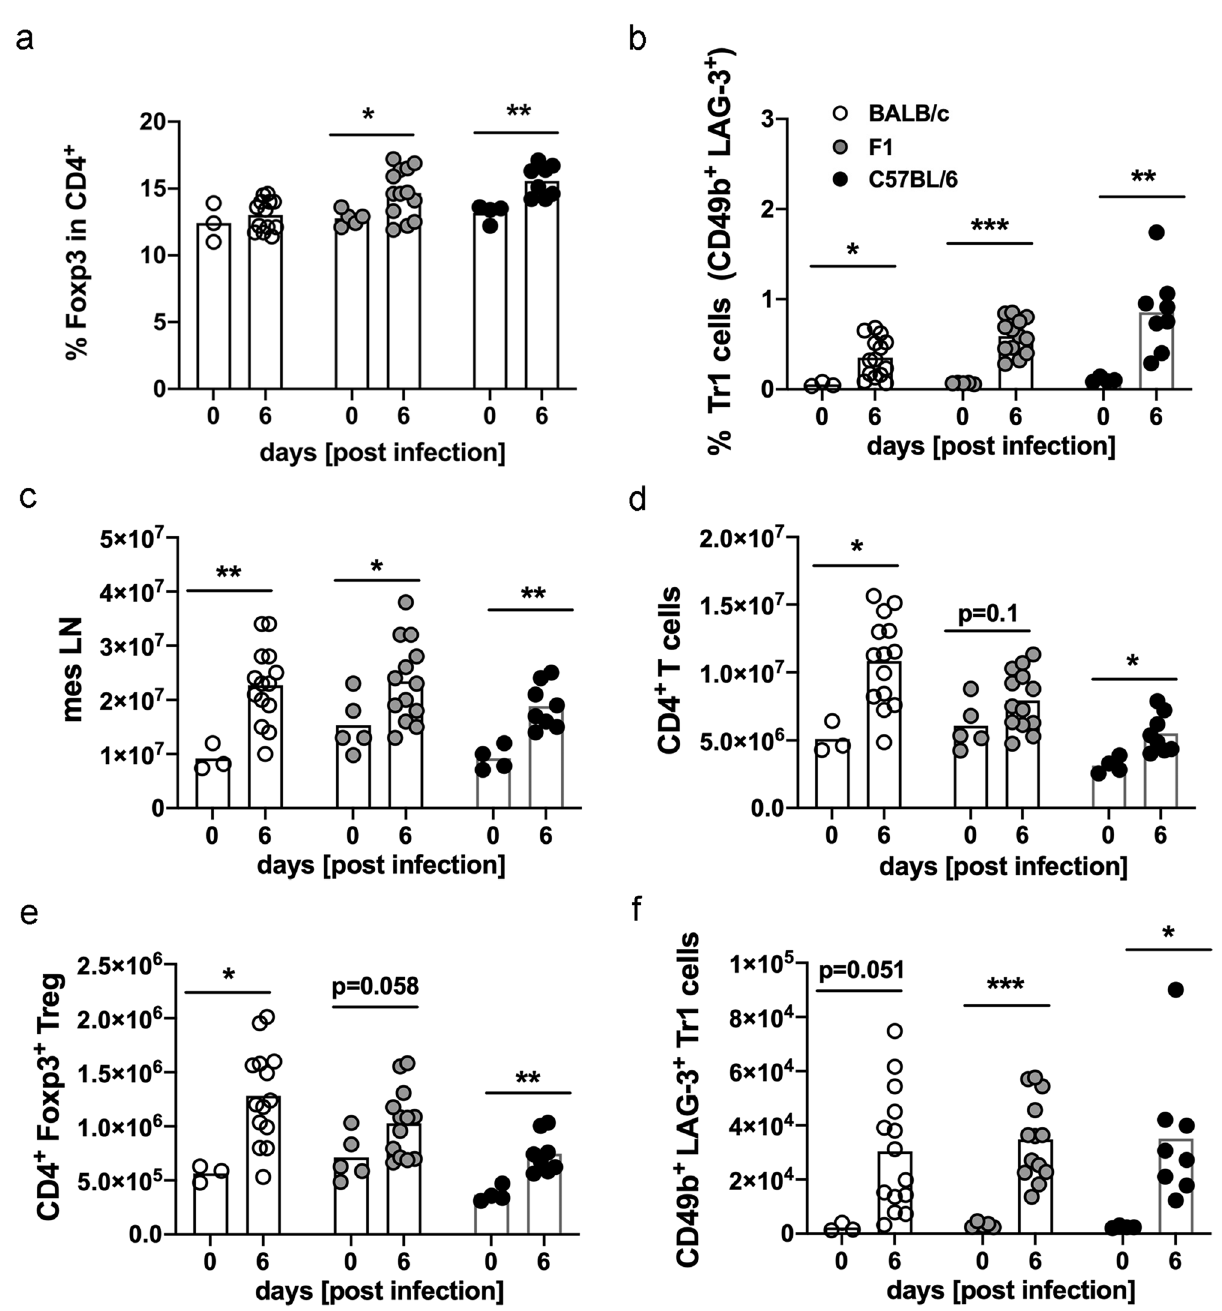
Figure 2. Treg and Tr1 cells increase during infection with S. ratti. BALB/c, F1 and C57BL/6 mice were left naïve (day 0) or infected with 2000 iL3. Six days later mes LN were isolated and stained with a panel for regulatory receptors. Frequencies of ( a ) Foxp3 + cells in CD4 + T cells and ( b ) Tr1 cells in Foxp3 − CD4 + T cells are shown. Numbers of mes LN ( c ), CD4 + T cells ( d ), Foxp3 + Treg ( e ), and CD49b + LAG-3 + Tr1 cells ( f ). Each symbol represents values from a single mouse. Shown are combined results from 2–3 experiments (BALB/c day 0 p.i.: n = 3, day 6 p.i.: n = 14; F1 day 0 p.i.: n = 5, day 6 p.i.: n = 13; C57BL/6 day 0 p.i.: n = 4 mice, day 6 p.i.: n = 8). Data were analyzed by an unpaired t-test. Asterisks indicate significant differences of the mean (*p ≤ 0.05, **p ≤ 0.005, ***p ≤ Treg are central in the regulation of the anti‑helminth immune response in F1 mice. Since we have previously shown that Treg significantly suppress the anti- S. ratti immune response in BALB/c mice 3 , we now aimed to compare the impact of Foxp3 + Treg in BALB/c and C57BL/6 mice and their F1 generation. To this end, we made use of the DEREG mice, which allow the depletion of Treg by application of diphtheria toxin (DT) 24 . To generate F1 DEREG mice, C57BL/6 DEREG mice were crossed with BALB/c mice and vice versa. We